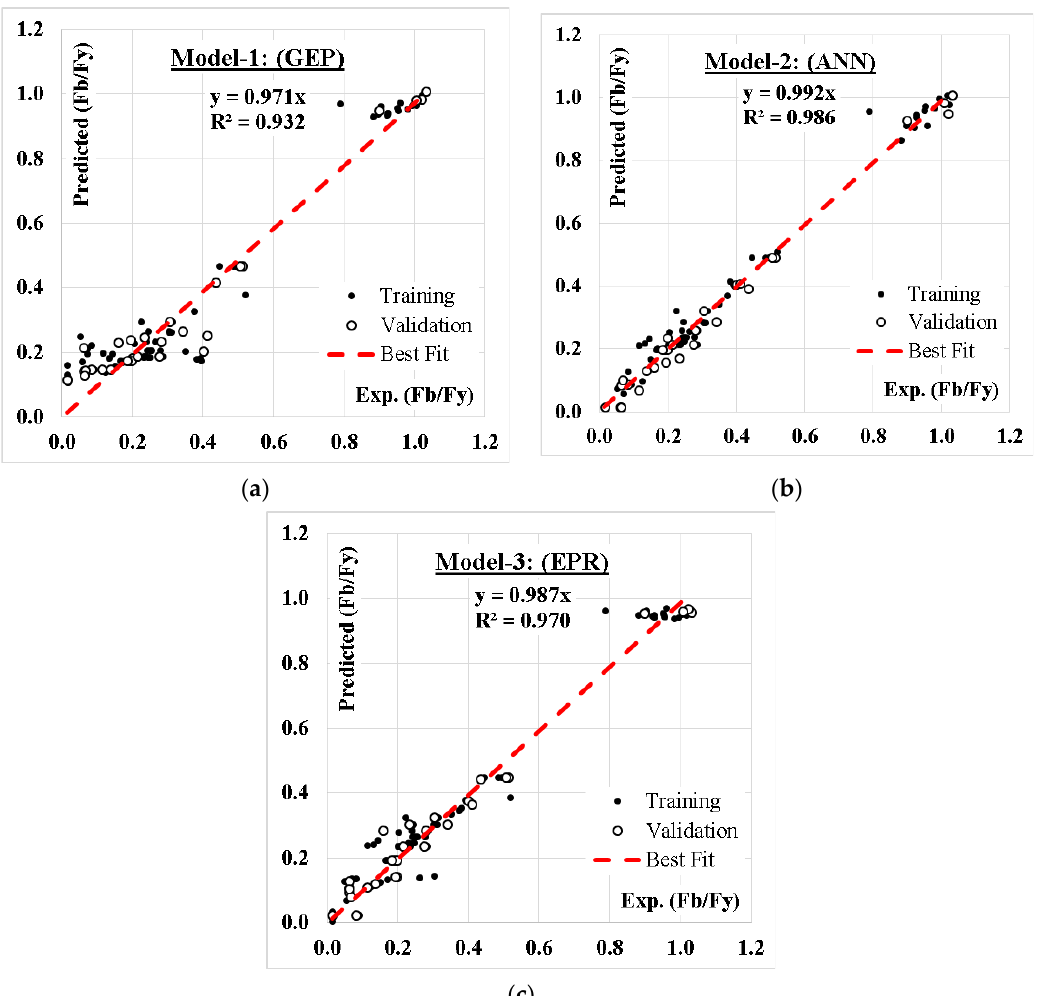
Figure 6. Relation between predicted and calculated Fb/Fy values using the developed models. ( a ) using GEP, ( b ) using ANN & ( c ) using EPR. Table 4. Accuracies of developed models.